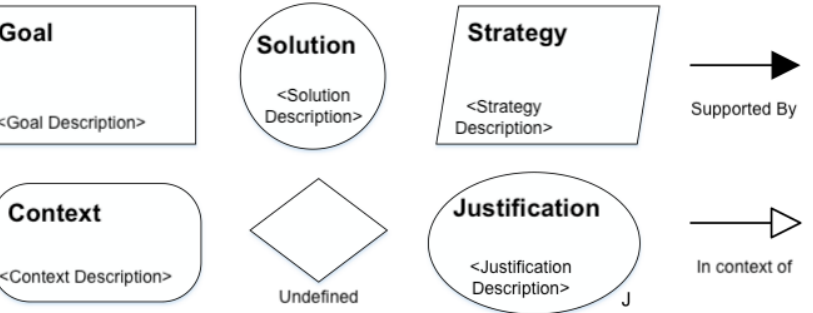
Figure 1. The main components of GSN: Goal , Solution , Strategy , Context , Justification , Undefined , SupportedBy , and InContextOf